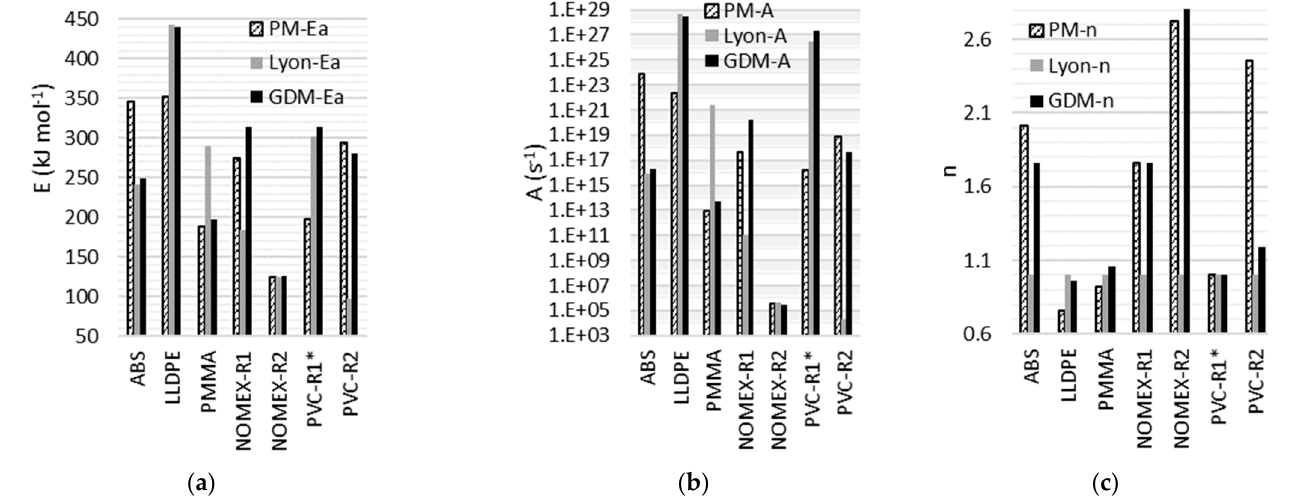
Figure 10. A comparison of the ( a ) activation energies, ( b ) pre-exponential factors, and ( c ) reaction orders of polymer materials at 10 K min − 1 obtained by different kinetic methods.